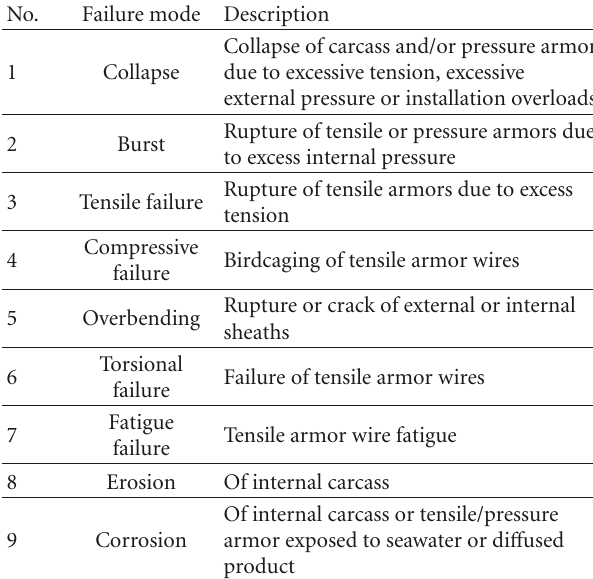
Table 2: Main failure modes of flexible